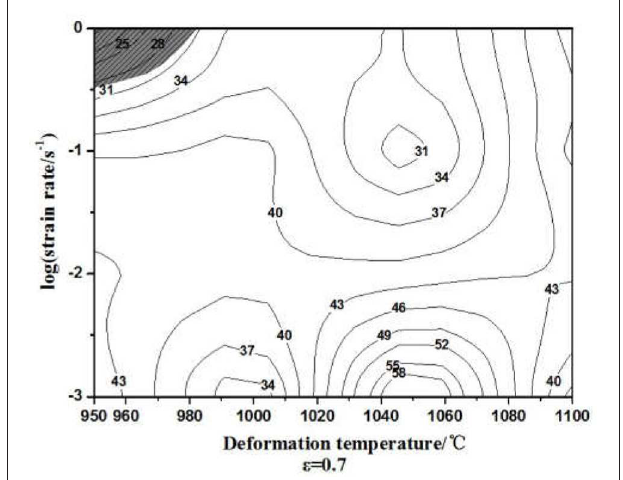
FIGURE 6 | The Processing map of the Ti-25.5Al-13.5Nb-2.8Mo-1.8Fe alloys under a strain of 0.7.